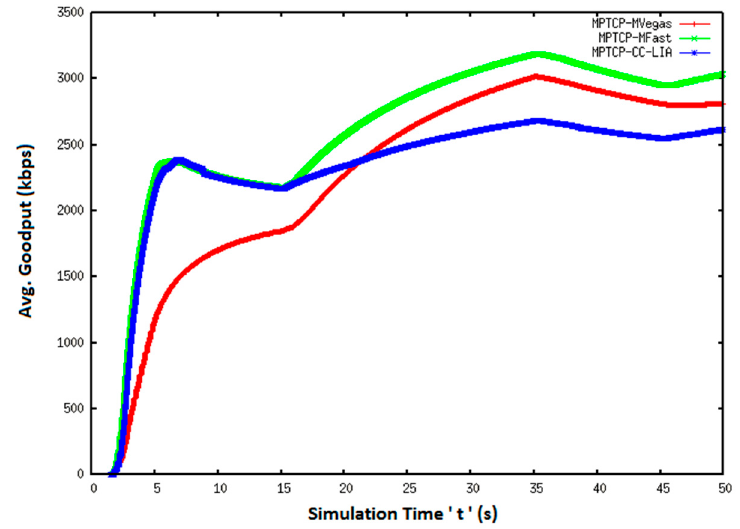
Figure 6. Average goodput result of Setup 1.